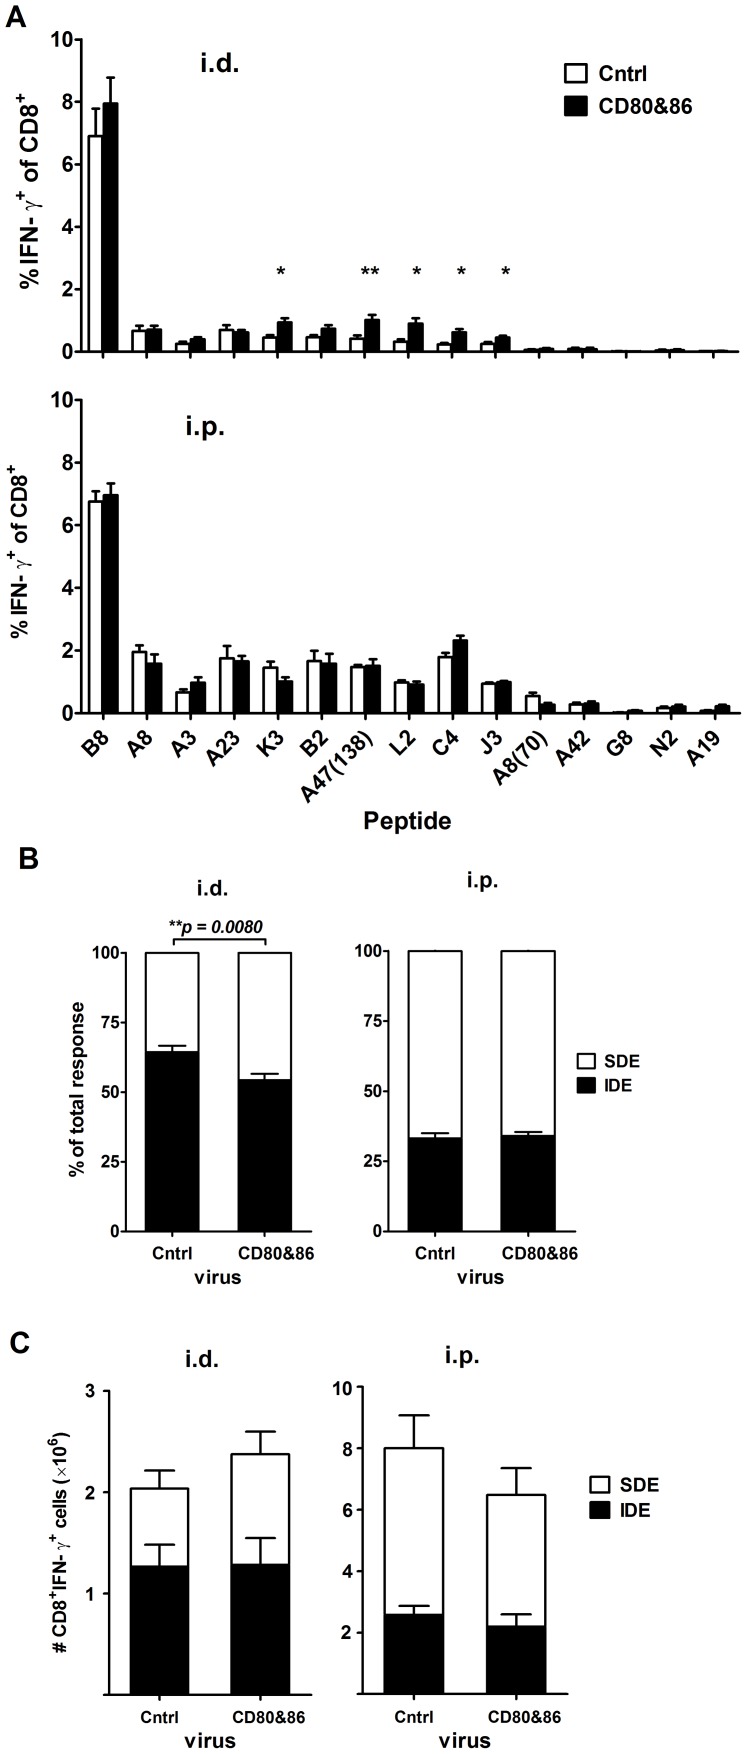
Immunodominance in i.d. but not i.p. infected mice was reduced by over-expression of CD80 and CD86.CD8+ T cell responses to VACV epitopes were determined in C57BL/6 mice infected i.d. with 1×104 PFU of VACV-CD80&86 or control virus (VSC-8) or i.p. with 1×106 PFU of the same viruses. Seven days later, CD8+ T cell responses to 15 VACV epitopes were measured by intracellular staining of IFN-γ. Data are from two experiments and a total of 8 and 6 mice per virus for i.d. and i.p. respectively; route is shown above each graph. A) Means and SEM of percent of CD8+ T cells responding to each peptide. * p<0.05, ** p<0.01. B) The fraction of all measured responses accounted for by B820-specific (IDE) and the sum of SDE-specific CD8+ T cells. Statistical significance denoted with p value over appropriate bars. C) Responses to VACV epitopes broken down into IDE and SDE as in panel B, but shown as total numbers of CD8+IFN-γ+ cells per spleen.